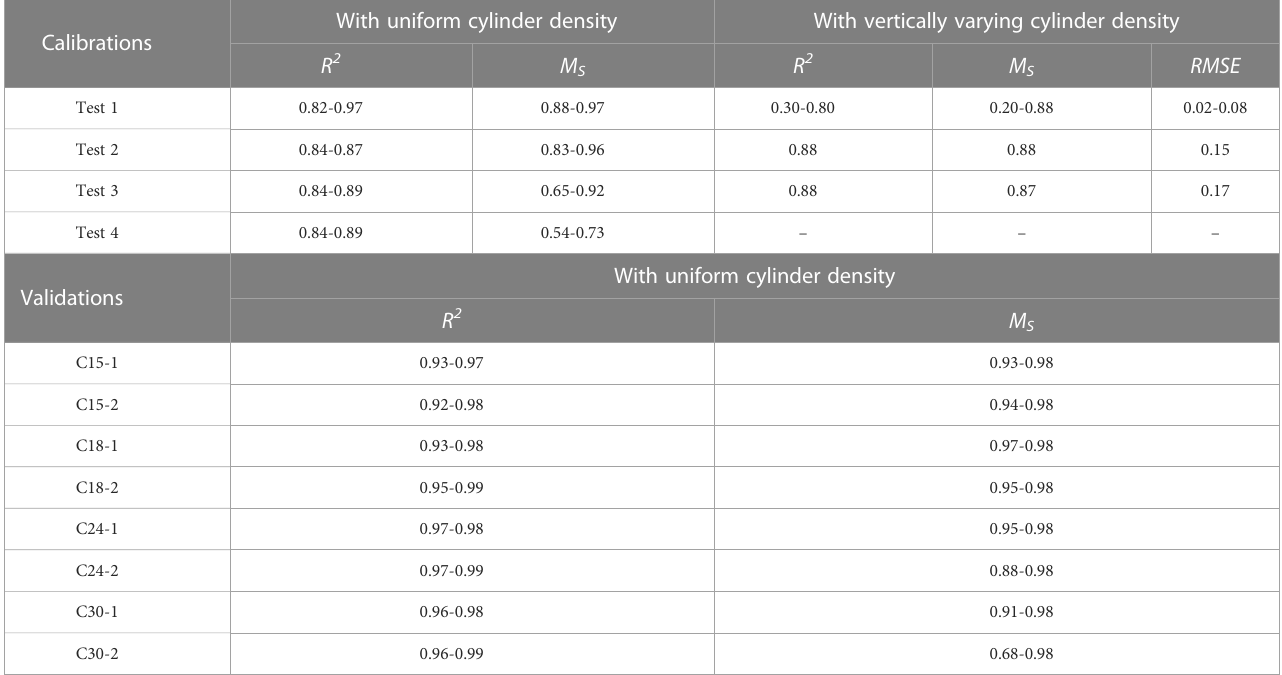
TABLE 4 Accuracy of model calibrations and